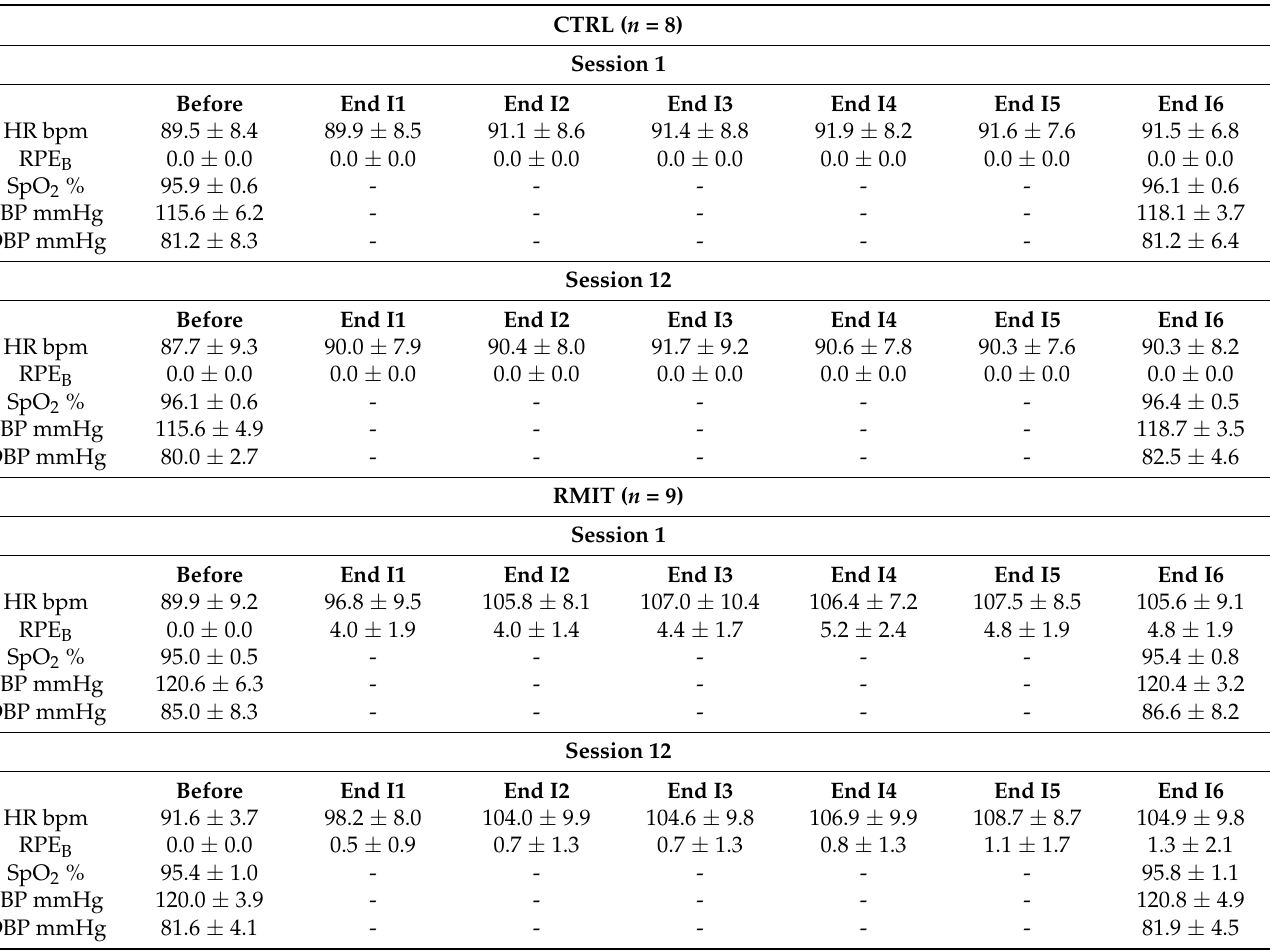
RMIT, respiratory muscle interval training intervention. n , no. of patients. HR, heart rate. RPE B , rate of perceived exertion for respiratory discomfort. SpO 2 , arterial blood O 2 saturation. SBP, systolic blood pressure. DBP, diastolic blood